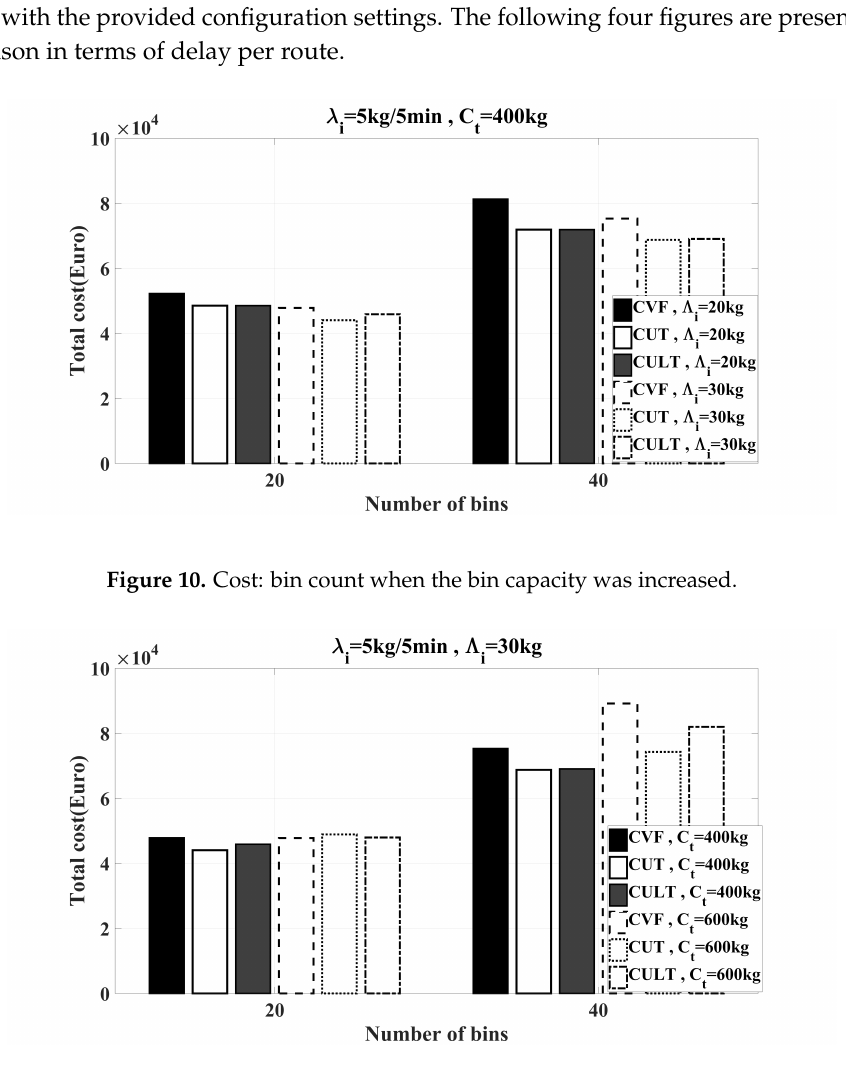
Figure 11. Cost: bin count when the truck capacity was